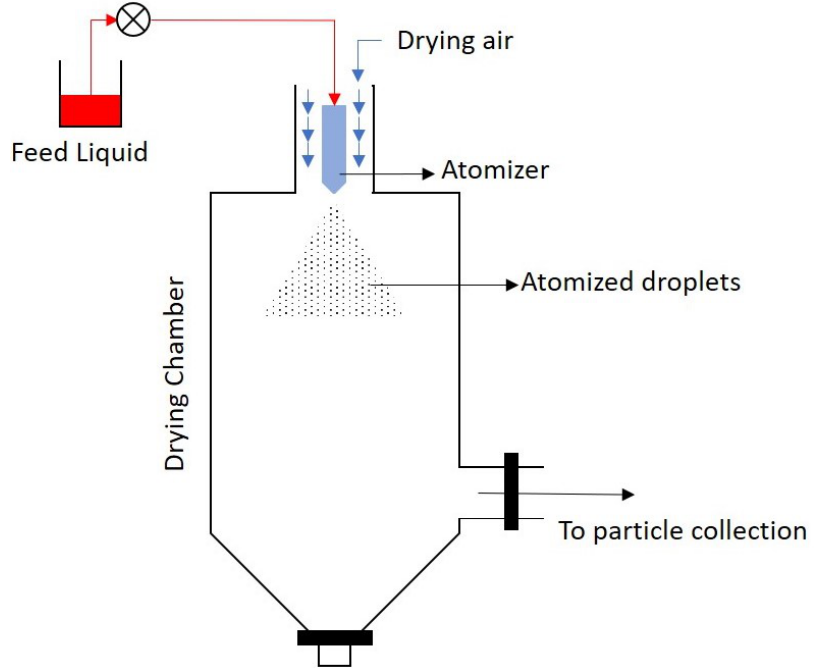
Figure 1. Schematic of a spray